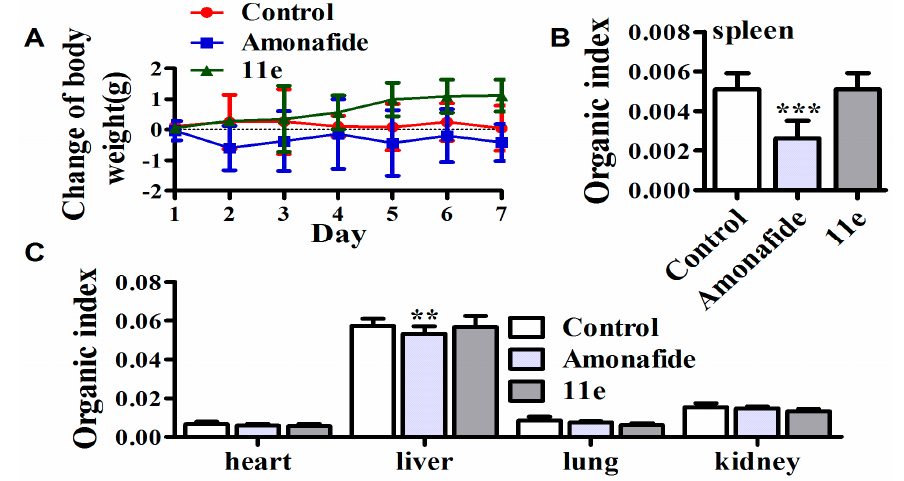
Figure 5. Systemic toxicity of 11e . ( A ) The changes of body weight of mice treated with 11e , amonafide, and normal saline; ( B ) The organ indexes of immune organ (spleen) were evaluated after treatment with 11e , amonafide, and normal saline ( n = 3, x ± SD *** p < 0.001); ( C ) The organ indexes (heart, liver, kidney and lung) were evaluated after treatment with 11e , amonafide, and normal saline ( n = 3, x ± s ** p < 0.01).